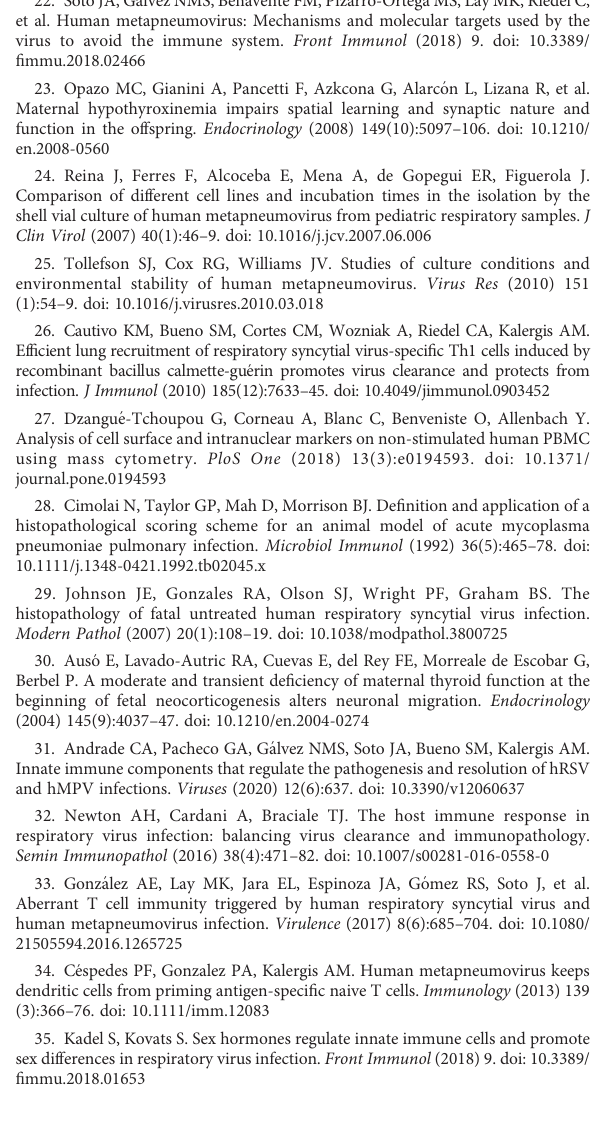
SUPPLEMENTARY FIGURE 5 Bronchial structure in the progeny of Hpx mothers. Lung sections from non-infected Eut, Hpx, and Hpx+T 4 are shown at 10X with H&E stain. Representative images of histological sections (600 µm) are shown. The black arrow shows the alveolus (AD) and terminal bronchioles (BT) for each group (A) . The number of terminal bronchioles for each treatment is graphed (B) . The averages from six to eight animals per group ± SEM are shown and analyzed by one-way ANOVA.